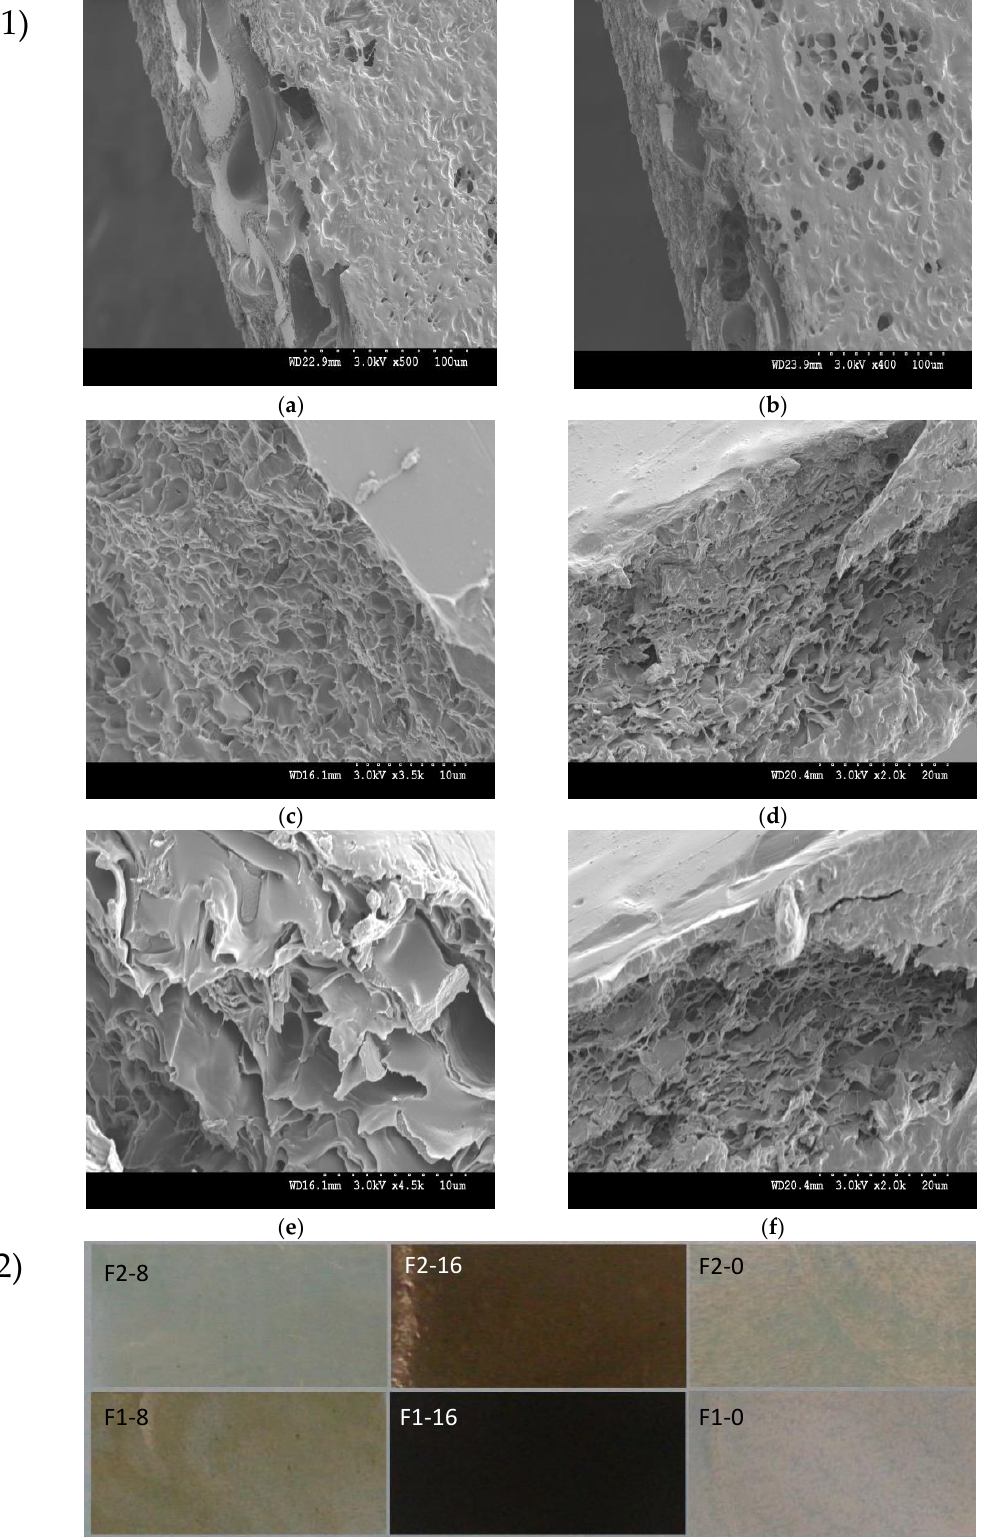
Figure 6. ( 1 ) Investigation of cross-sectional morphology of porous composite films of ASC-g-P(MMA-co-EA) without GO contents: ( a ) F1-0, ( b ) F2-0; the multilayer nanostructure of ASC-g-P(MMA-co-EA) with GO contents: ( c ) F1-8, ( d ) F1-16, ( e ) F2-8, ( f ) F2-16; and, ( 2 ) the color appearances of nanocomposite films on a light blue